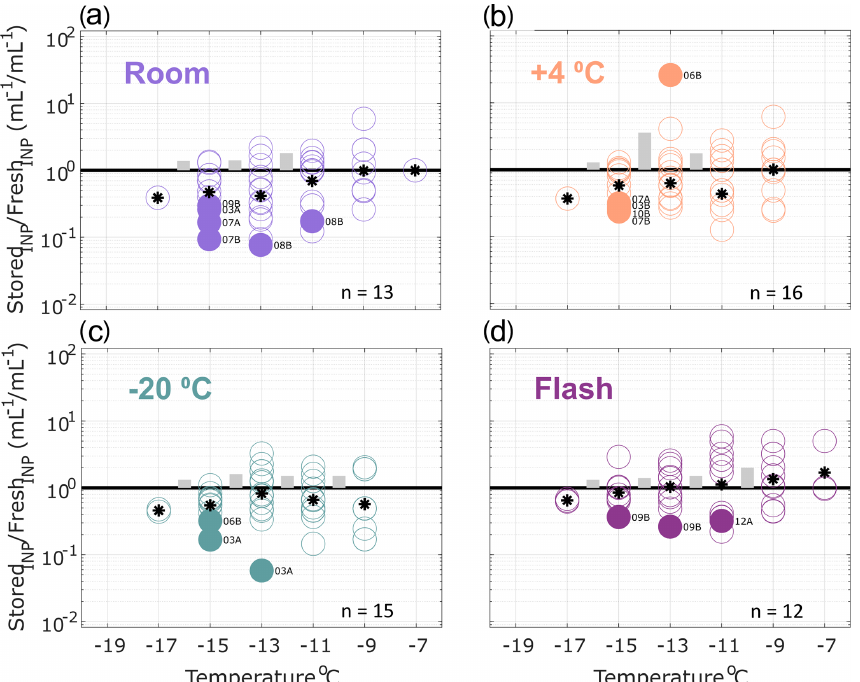
Figure 3. Ratio of INP concentrations measured in heated precipitation samples (stored:fresh), calculated in successive 2 ◦ C increments between − 19 and − 7 ◦ C. Same samples as shown in Fig. 2 but heated to 95 ◦ C for 20min prior to measurement to eliminate heat-labile INPs (see Methods Sect. 2.2 for details). All samples were processed at one or two time intervals between 1 and 166d postcollection. For samples processed at two intervals, both replicate samples are represented in the figure for a total of 13, 16, 15 and 12 samples in panels (a) , (b) , (c) and (d) , respectively (see Table 3 for summary of sample and replicate numbers). In temperature intervals containing stored:fresh ratios from at least two sets of replicate samples, grey bars represent the average difference between replicates. Results show significant losses of INPs in heat-treated samples stored at room temperature. Refrigerated, frozen and flash-frozen samples show comparable results with a few (1–3) samples exhibiting significant losses and enhancements. Non-heat-labile INPs are generally less sensitive to storage protocol than the total INP population in precipitation samples (Fig. 2), with the exception of storage at room